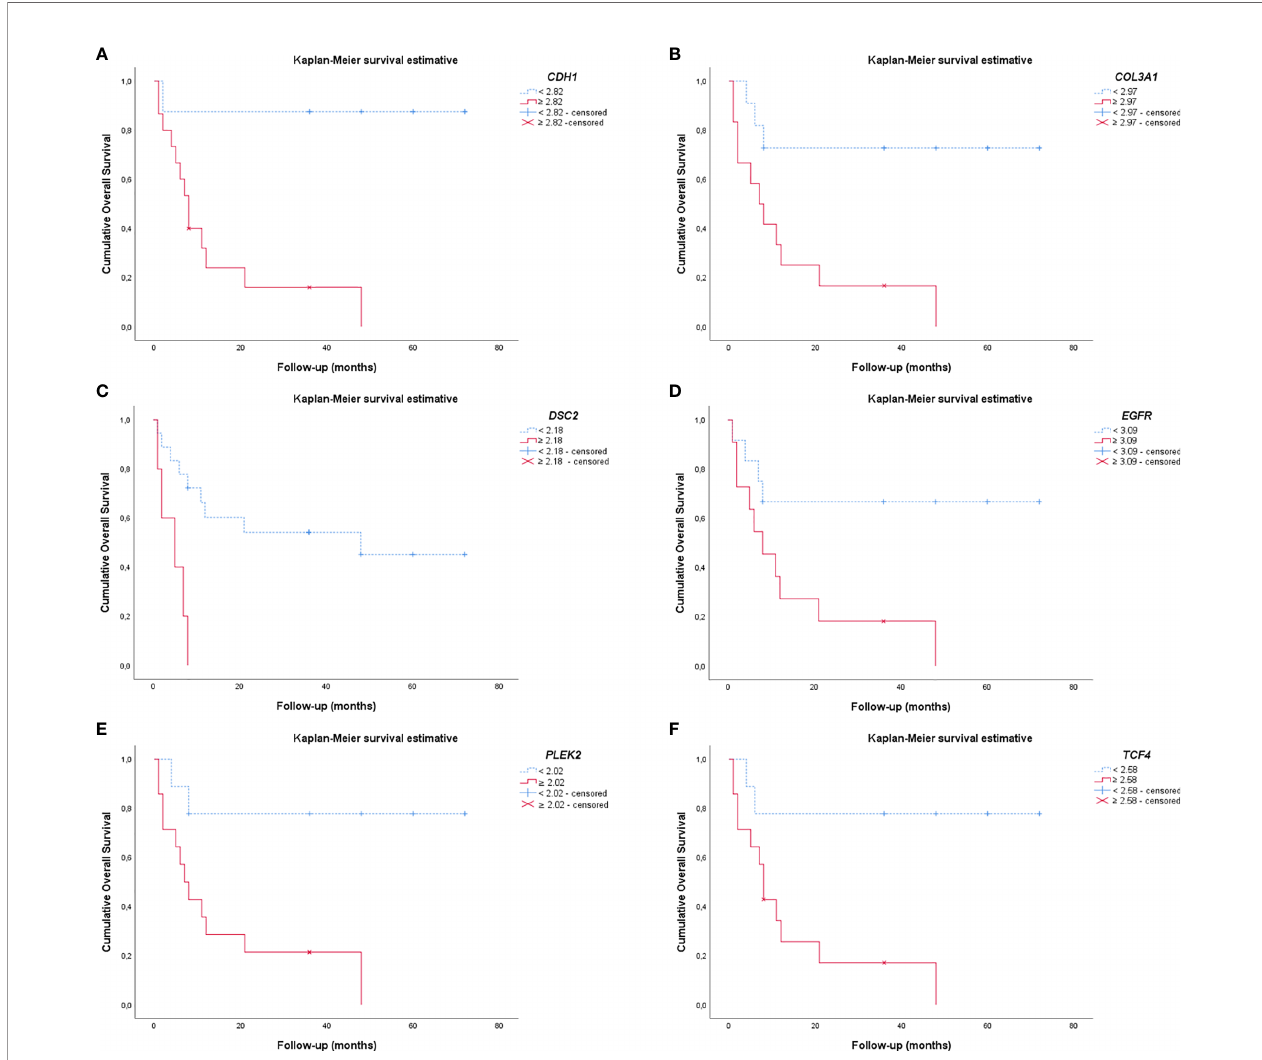
FIGURE 7 | Kaplan-Meier curves show the difference in EMT gene expression between patients regarding the PNENs variants and the risk of death. (A) CDH1 ; (B) COL3A1 ; (C) DSC2 ; (D) EGFR ; (E) PLEK2 and (F) TCF4 . For all these EMT genes, patients that had lower expression appeared as the top curve, and their median survival time ranged between 40-63 months. In contrast, patients with higher expression of these genes (bottom curve) had a median survival time range of 4-15 months (P ≤ 0.01 by log-rank